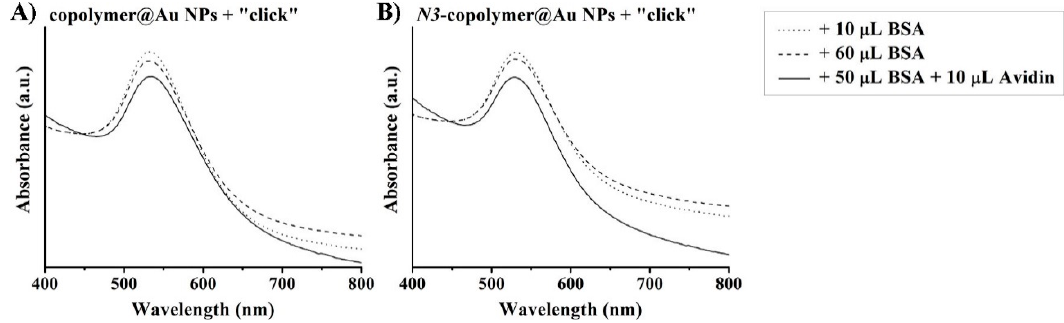
Figure 7. Visible spectra of ( A ) “click control” and ( B ) biotin –copolymer@Au NPs mixed with BSA (30 min) before adding avidin. The spectra were normalized at 450 nm.